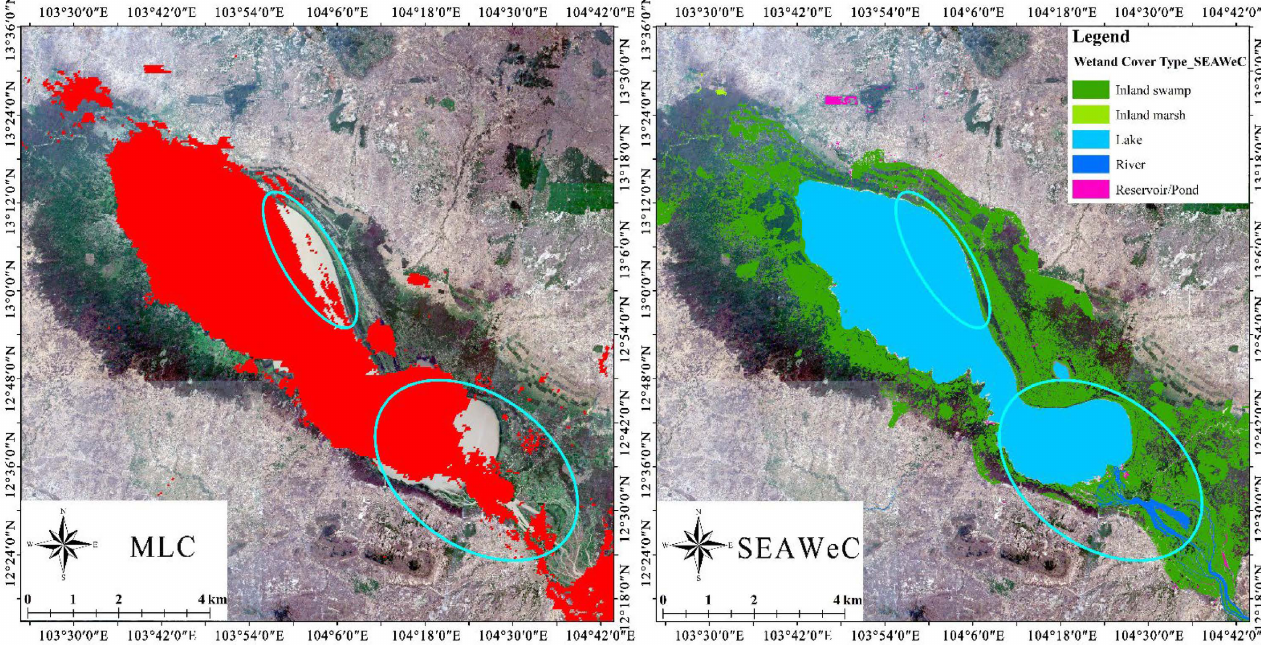
Figure 13. A comparison of the SEAWeC from the MLC